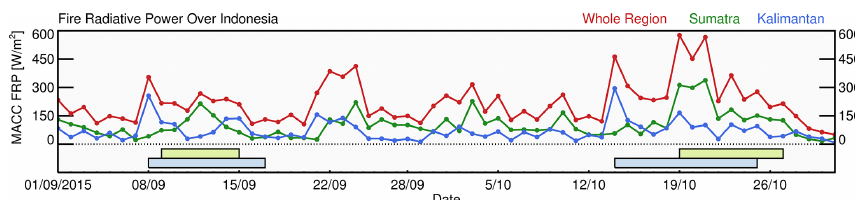
Figure 8. Daily fire radiative power density (red line) taken from the Global Fire Assimilation System (GFAS) (Kaiser et al., 2012), op- erated as part of CAMS. Data are shown from 1 September to 31 October 2015, for the entire Indonesian landmass (red) and separately for the regions of Sumatra and Kalimantan. Two specific time periods are highlighted (referred to as Period 1 and Period 2), Period 1 cov- ering 9–15 September (Sumatra) and 8–17 September (Kalimantan) and Period 2 covering 19–27 October (Sumatra) and 14–25 October (Kalimantan).